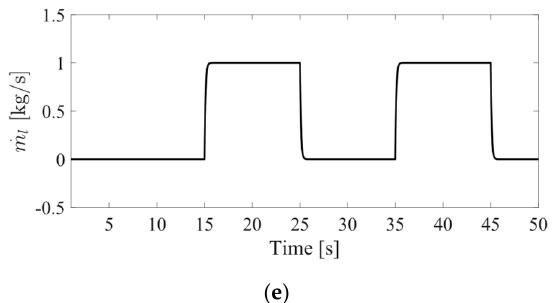
Figure 6. Performance of the proposed designs in a firefighting mission. ( a ) Tracking performance in three-dimensional geometry; ( b ) Time responses of translations and rotations; ( c ) three-dimensional partial motion of the water-conveying hose; ( d ) Control inputs; ( e ) Fire extinguishing nozzle’s fl ow rate.